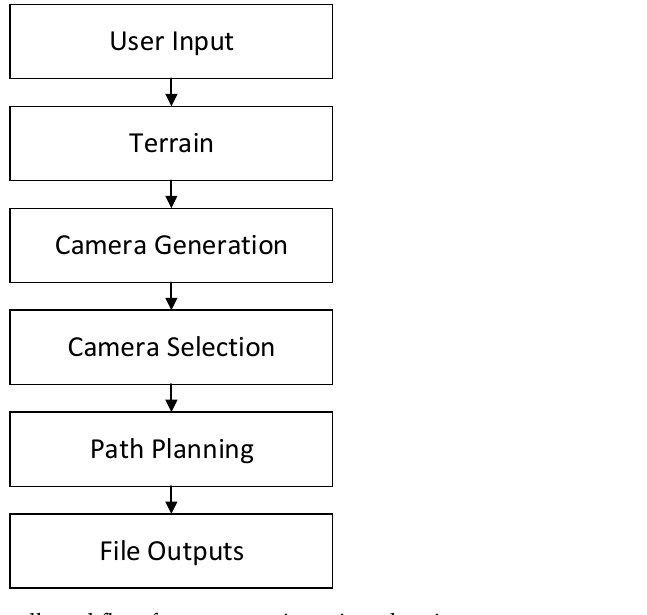
Figure 2. Overall workflow for camera orientation